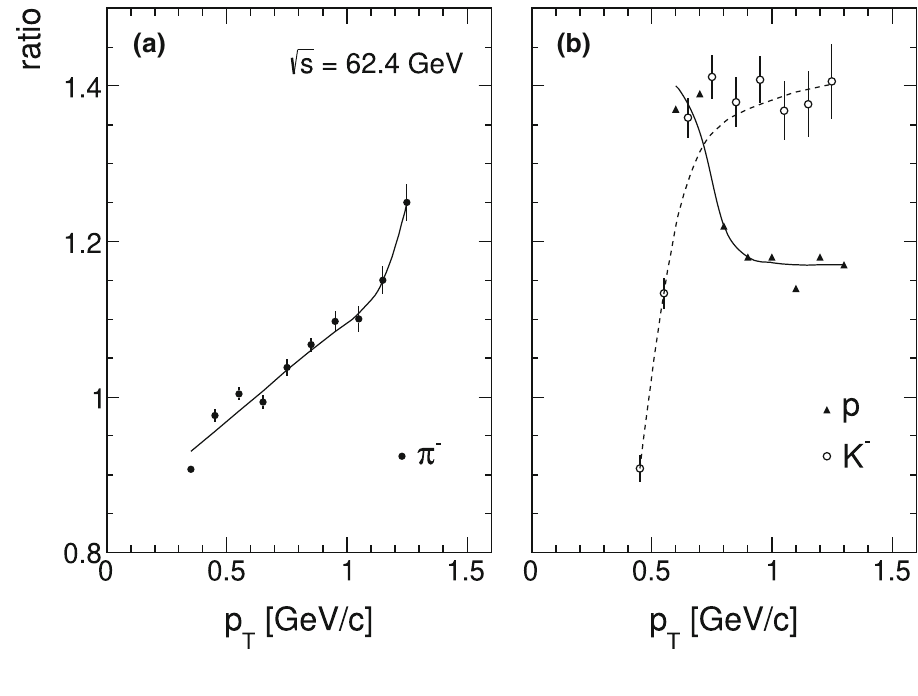
Fig. 75 Cross section ratios between the RHIC data and the ISR results as a function of p T for a π − (full circles and full line), b K − (open circles and broken line) and p (full triangles and full line). The lines are given to guide the